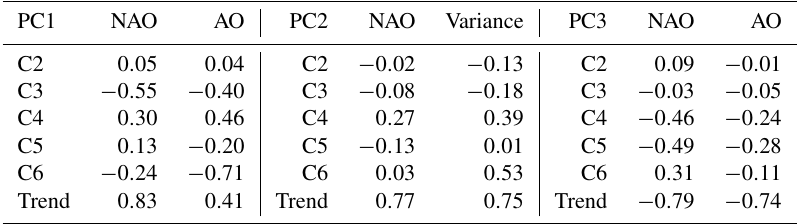
Table 5. The correlations between the first three EOF sea ice drift patterns on various timescales and a variety of large-scale atmospheric